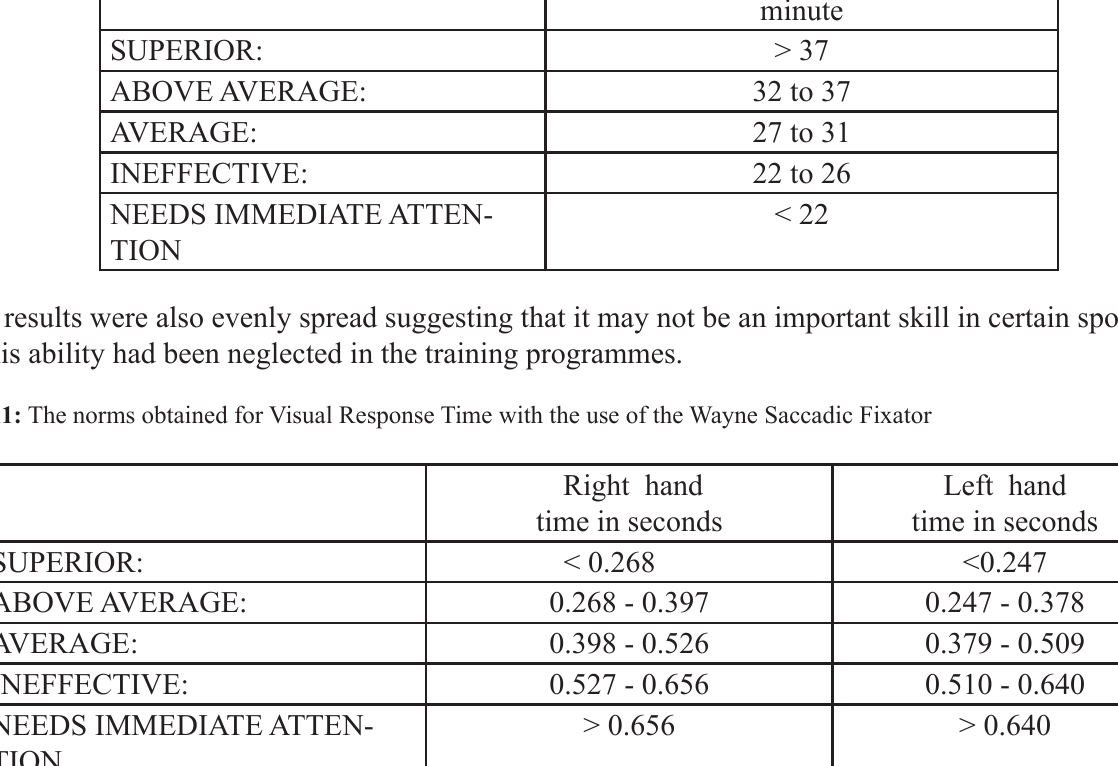
Table 10: The norms obtained for Eye-Body Coordination with a balance board that was connected to a Wayne Saccadic Fixator Number of correct responses in 1